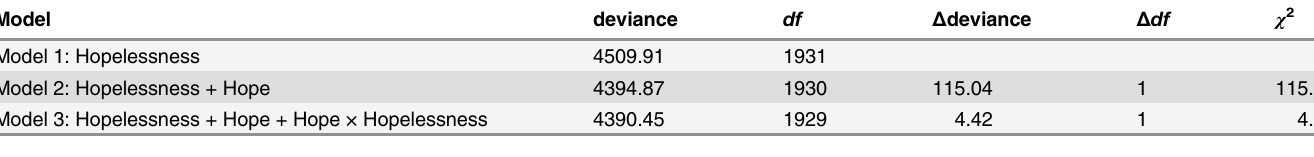
Table 4. Analysis of Deviance for Negative Binomial Analyses Predicting Suicidal Ideation.